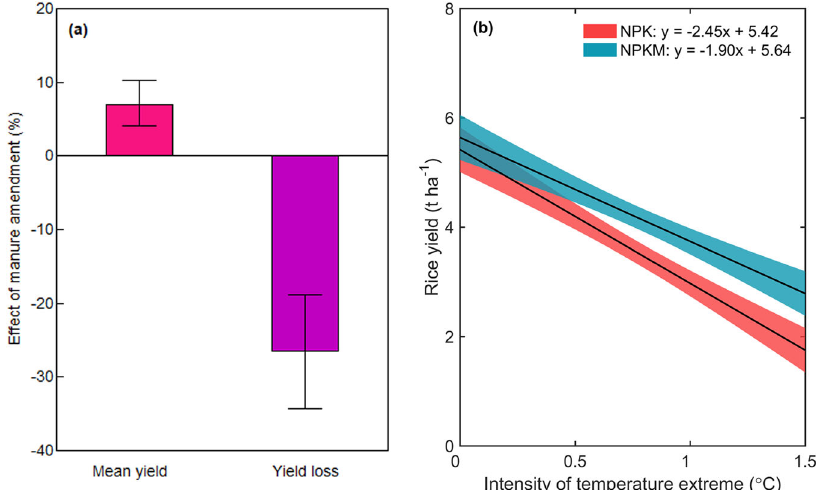
Fig. 2 Results from a meta-analysis investigating the effect of long-term manure amendment on rice yield. a Effect of long-term manure amendment on rice yield ( n = 45) and rice yield losses with extreme temperatures ( n = 45). b Relationship between the intensity of temperature extremes and rice yield for inorganic fertilizer (NPK) and a combination of manure and inorganic fertilizer (NPKM). Error bars and shaded areas represent 95% con fi dence